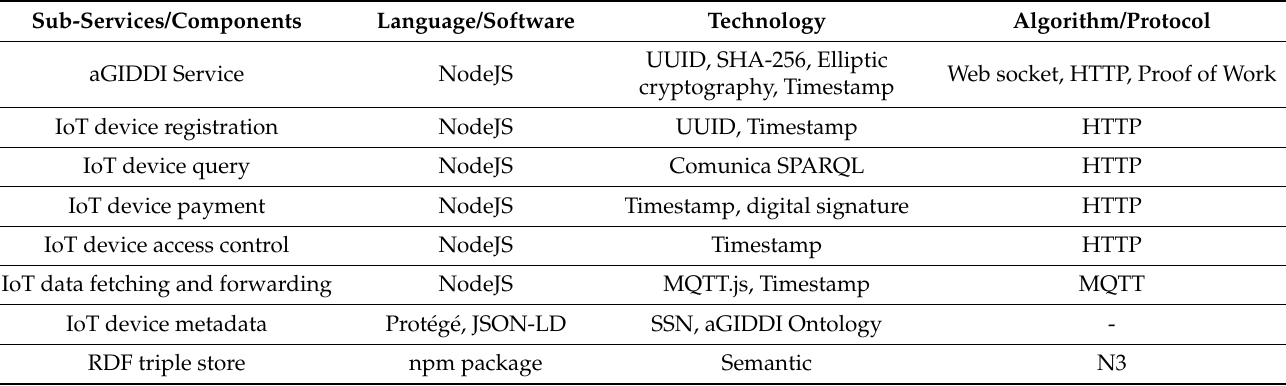
Table 1. aGIDDI implementation